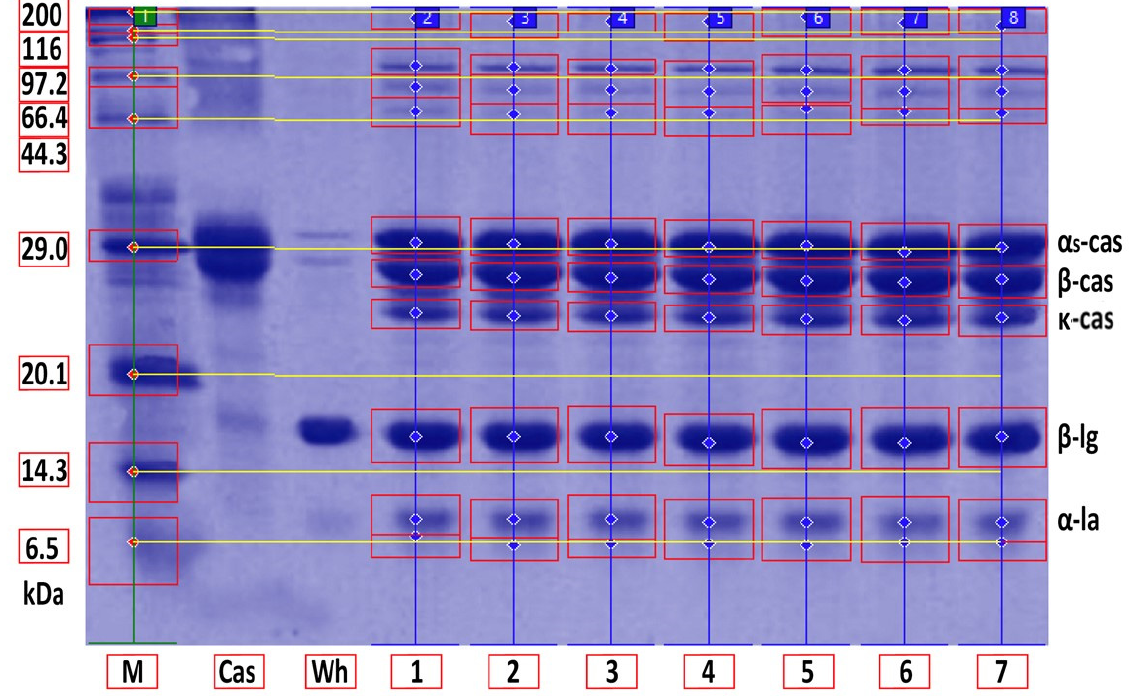
Figure 11. SDS-PAGE of whey and casein protein fractions after heating at 75 ° C for different times. M—molecular marker; Cas—casein; Wh—whey protein; Lanes 1–7: raw milk, milk heat-treated for 5, 10, 15, 20, 25 and 30 min.